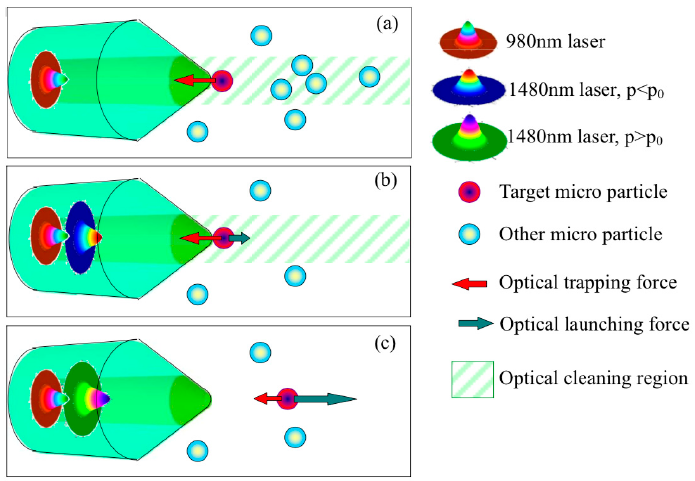
Figure 3. Schematic diagram of the dual-wavelength single fiber optical tweezers [39]. ( a ) Optical trapping force generated by the 980 nm laser beam. ( b ) Optical launching force generated by the 1480